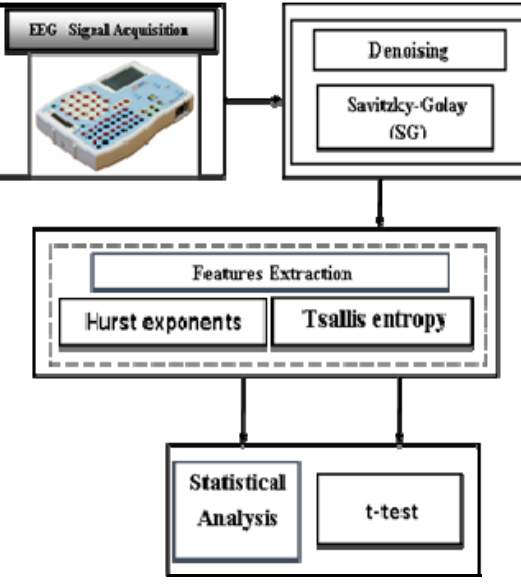
Fig. 1. The block diagram of the current study